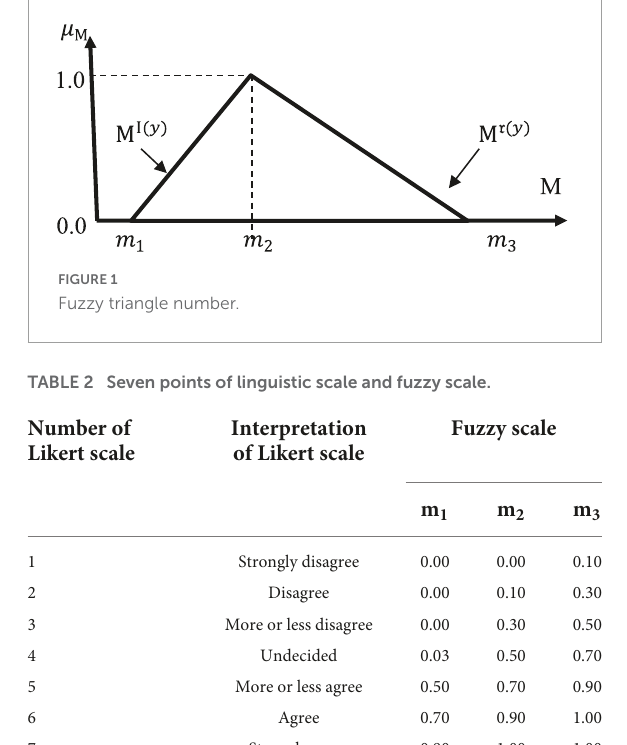
TABLE 3 Different interpretation of Likert scale and fuzzy